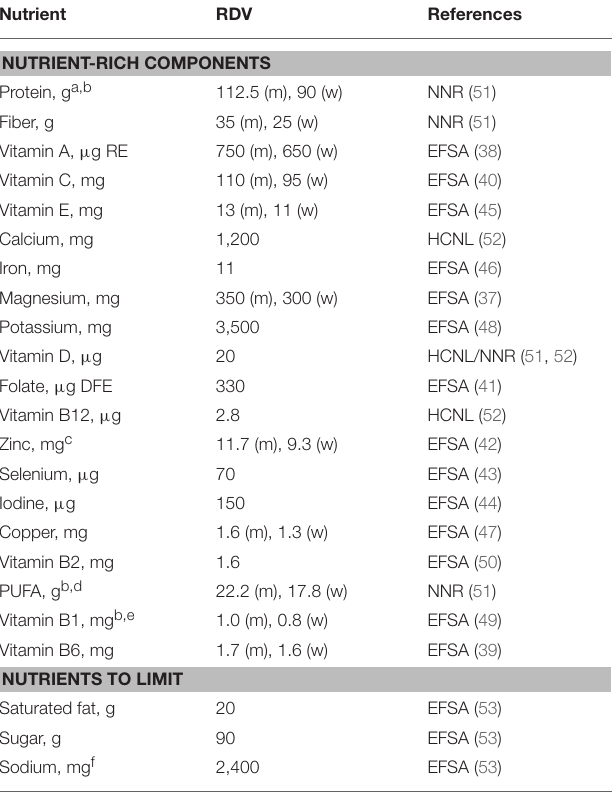
TABLE 3 | Algorithms used to calculate the E-NRF index scores.